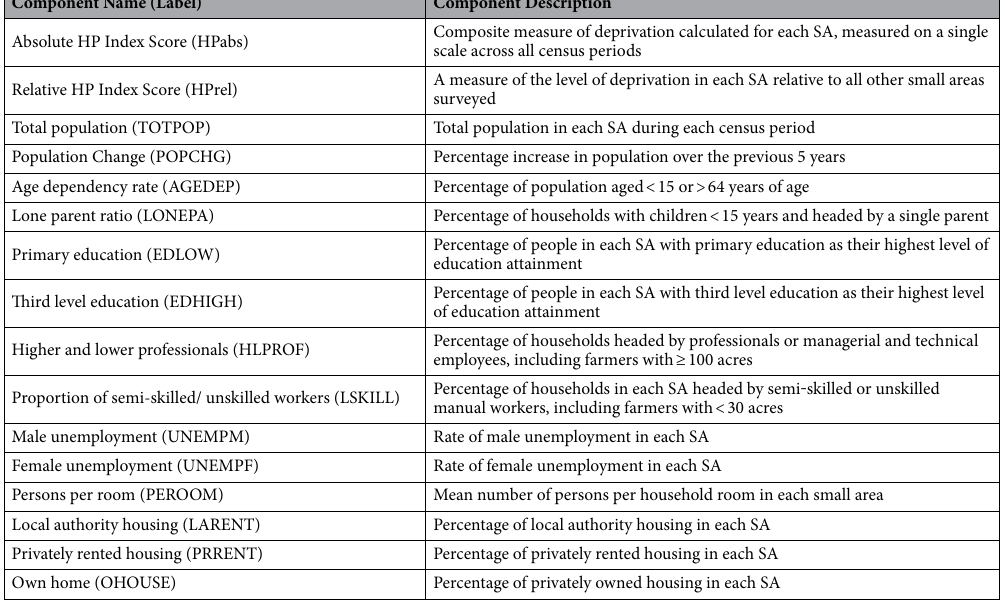
influence) was recoded as commuter/peri-urban, with all other areas (classification 6) coded as ‘rural’. Deprivation index and components. The Pobal Haase-Pratschke (HP) Deprivation Index is a composite meas- ure of deprivation/affluence derived from national population census data and comprising 16 individual compo- nents, representing three dimensions of deprivation: demographic profile, social class composition, and labour market situation (Table 1) 15 . The absolute deprivation score reflects any changes to the national economy at SA level between census periods while the relative deprivation index score is a comparative measure of depriva- tion between SAs during a census period 15 . Deprivation indices (absolute and relative) and component scores were obtained for the most recent (2016) national census of Ireland and attributed to all laboratory-confirmed COVID-19 cases. Statistical analysis. To counteract the high proportion of “non-severe” outcomes within the case dataset, a balanced dataset was created via up-sampling. Cases were randomly partitioned into model training (80%) and validation (20%) subsets based on the dependent variable of interest (i.e., Hospital Inpatient, ICU Admission, Mortality), to derive generalised linear models using a binomial link function (i.e., dispersion = 1, parameter number = number of coefficients). Models were trained using all available predictors, with variables individu- ally removed from the model based on the lowest Akaike Information Criterion (AIC) and the least significant variable p value (i.e., stepwise approach). Each significant variable was subsequently removed from the model to assess its effect on model accuracy based on developed confusion matrices. Only variables contributing sig- nificantly to model accuracy were retained. Receiver operating characteristic (ROC) curves and the area under the curve (AUC) were employed to assess the diagnostic ability of developed models; internal validation was undertaken on calculated AUROCs using 500 bootstrapped samples for model training and validation. The Nagelkerke R 2 was used to calculate the proportion of explained variance explained by the selected predictors, with the Brier score used to assess model performance (calibration). The “best predictors” identified via validated GLMs were used to develop “rpart” (Recursive Partitioning and Regression Trees) models to identify individual variable thresholds and the causative pathways from sympto- matic infection to each of the three modelled outcomes (i.e., attribute cut-offs (“splitters”) and causative order/ importance). As for GLMs, a balanced dataset and partitioning approach (80/20) for training and testing sets were employed. A 10 × cross-validation tree development method was used, with tune length (number of default parameters) varying from 2 to 10 for training. Final models were selected to maximise the complexity/accuracy of the decision trees (based on Cp (complexity parameter)). Accordingly, presented models are those with the maximum number of predictors in concurrence with the highest level of accuracy based on true positives (i.e., sensitivity). Final decision trees are presented to highlight successive thresholds (cut-off values (splitters) for continuous predictors, significant category for categorical predictors, predictor order) and pathways (i.e., predictor order) identified for progression from symptomatic confirmed COVID-19 infection to each of the modelled outcomes.